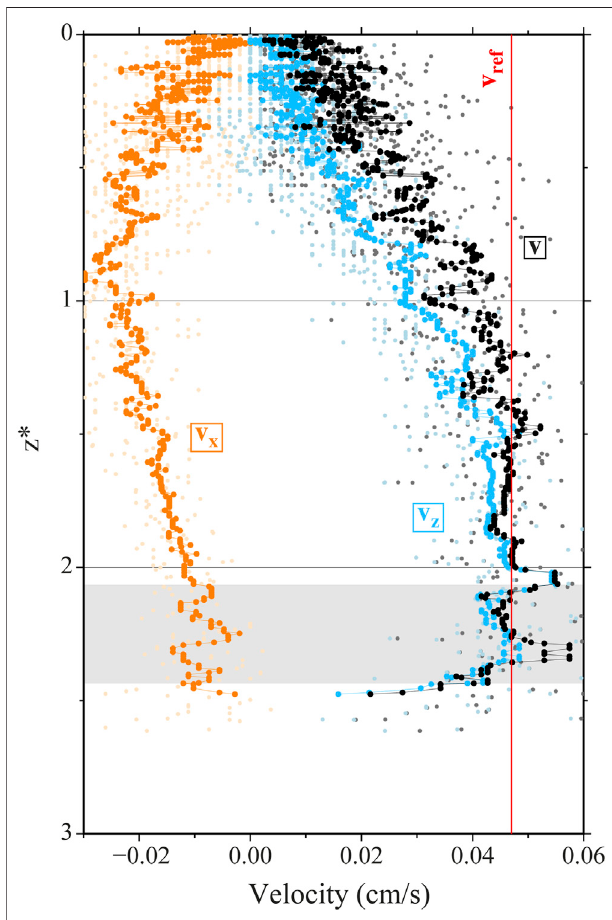
FIGURE 2 | Various components of the velocity of the crack recorded during experiment 61 (EXP61). The horizontal ( V x in orange) and vertical ( V z in blue) component of the velocity are obtained by deriving the position of the crack with regards to the time. The total velocity ( V represented in black) isthenormcalculatedfromthetwovelocity components. Pale dotsareforthe points given by TRACKER while the vivid ones are for the fi ltered values. The fi rst centimetre of the velocity at the bottom (grey area) is used to de fi ne a velocity of reference ( V ref ), expected to be close to the one observed for a vertically rising crack and represented by the red vertical